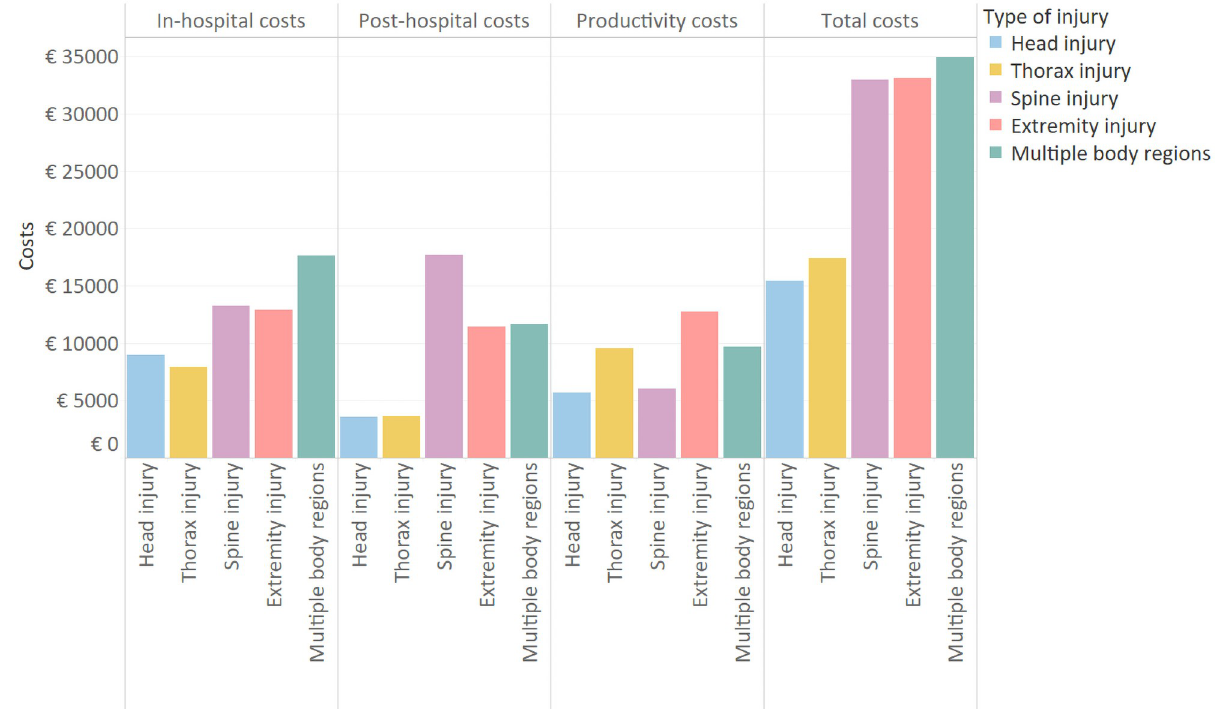
Fig 1. Mean health care and productivity costs by injured body